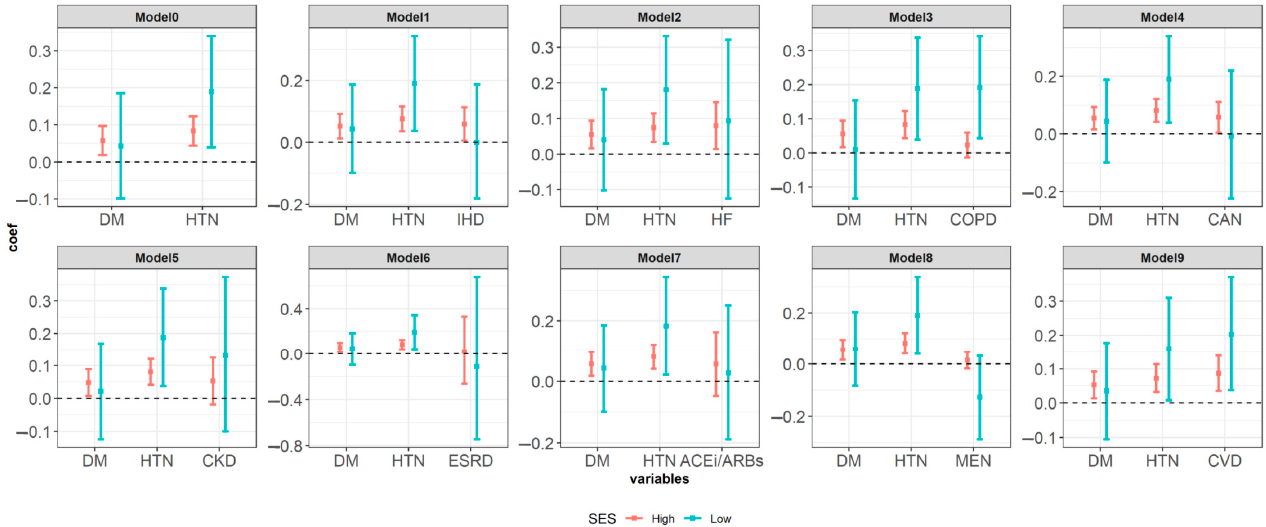
Figure 3. The effect of the underlying disease and whether or not taking ACEi/ARBs in the past or present on hospital stay according to the subgroup analysis based on the variable for classifying insurance types as a substitute variable for the socioeconomic status. Note: Model0: adjusted covariates age, sex and insurance type, Model1: adjusted covariates age, sex, insurance type and ischemic heart disease, Model2: adjusted covariates age, sex, insurance type and hear failure, Model3: adjusted covariates age, sex, insurance type and chronic obstructive pulmonary disease, Model4: adjusted covariates age, sex, insurance type and cancer, Model5: adjusted covariates age, sex, insurance type and chronic kidney disease, Model6: adjusted covariates age, sex, insurance type and end stage renal disease, Model7: adjusted covariates age, sex, insurance type and angiotensin converting enzyme inhibitors (ACEi) and angiotensin II receptor blockers (ARBs), Model8: adjusted covariates age, sex, insurance type and mental disorder. Model9: adjusted covariates age, sex, insurance type and cerebrovascular disease. DM, diabetic mellitus ; HTN hypertension; IHD ischemic heart disease; HF heart failure; COPD chronic obstructive pulmonary disease; CAN cancer; CKD chronic kidney disease; ESRD end stage renal disease; ACEi/ARBs angiotensin converting enzyme inhibitors (ACEi) and angiotensin II receptor blockers (ARBs); MEN mental disorder; CVD cerebrovascular disease.